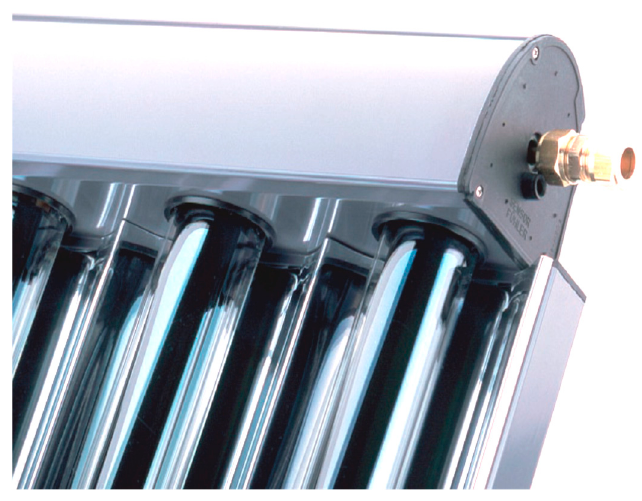
Figure 11. Common external concentrating CPC products.